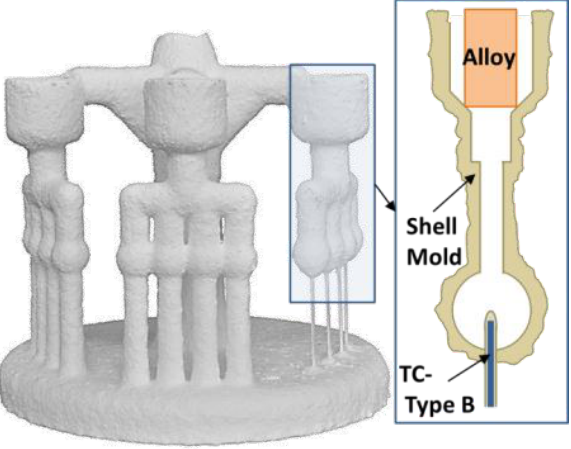
Figure 1. Shell mold for three different alloys furnished with type B thermocouples.